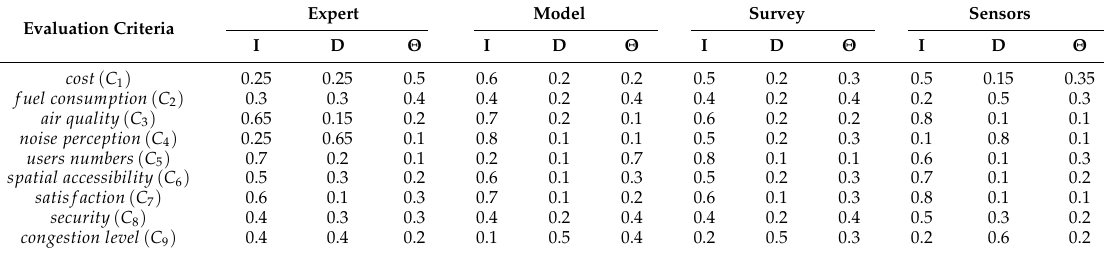
Table 4. Data collection of BPAs at the pre-test stage [20].